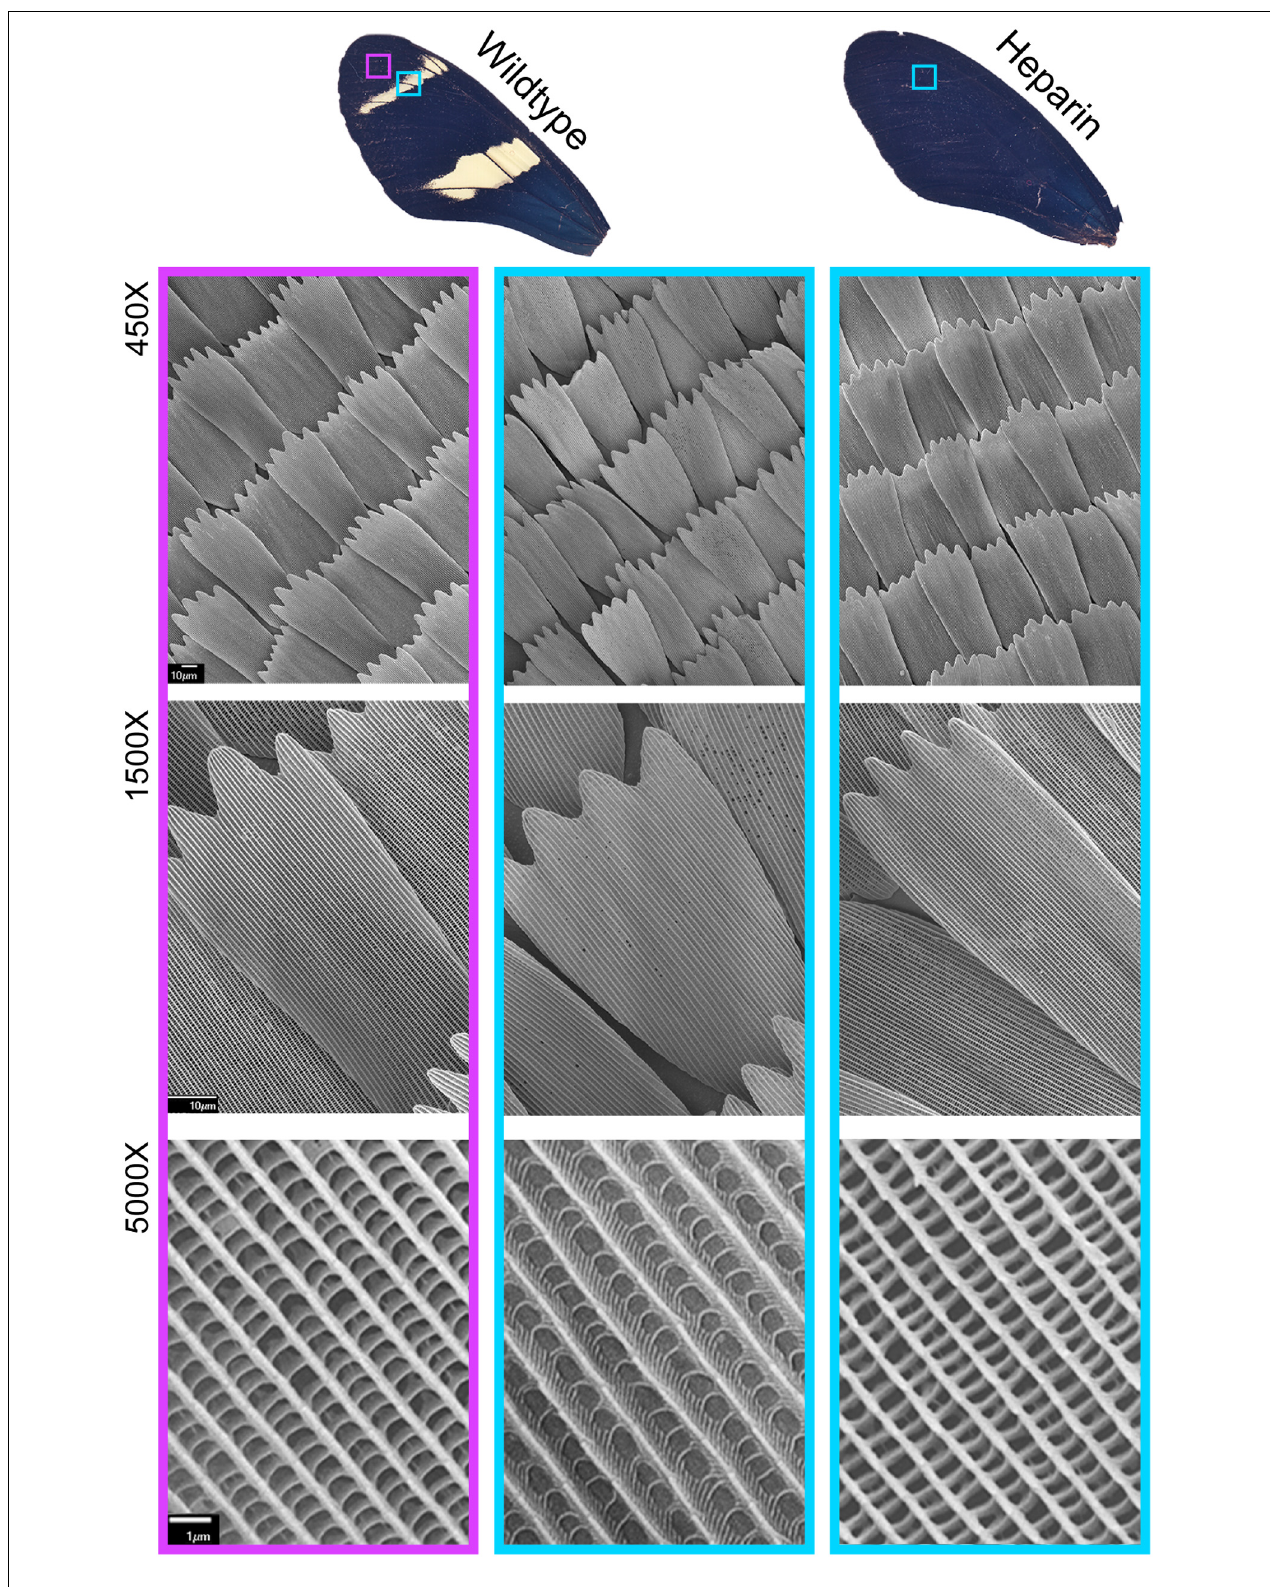
FIGURE 4 | Heparin impacts both scale pigmentation and structure in H. sara . Wings from Martin et al. (2012). Heparin injections result in yellow-to-blue/black scale color shifts, and SEM imaging reveals concordant changes in ultrastructure (5000X).